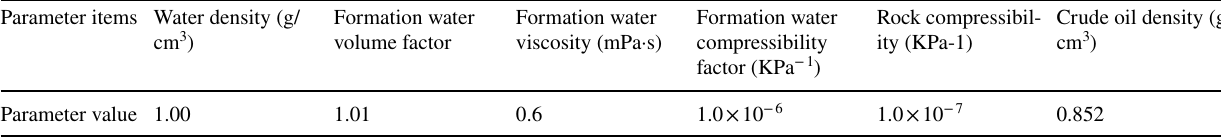
Table 1 The physical properties of reservoir and fluid in the model Parameter items Water density (g/ cm 3 )